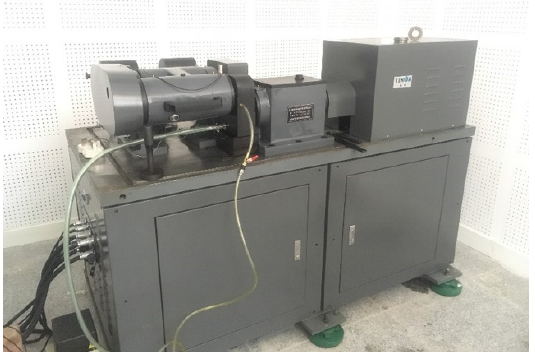
Figure 2. Photograph of the GPM-30D twin-disc wear testing machine.